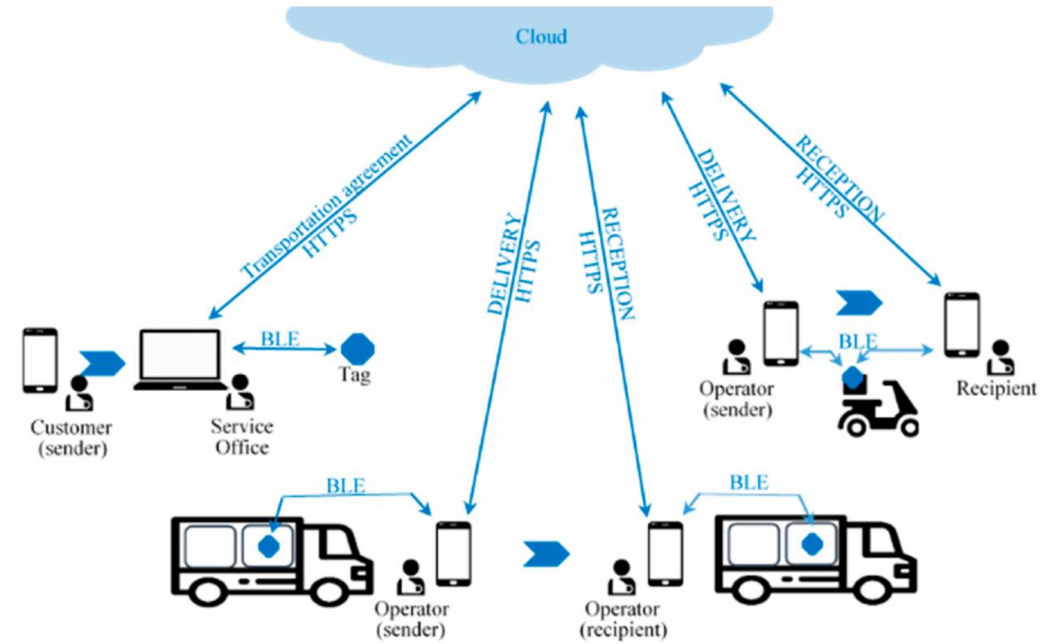
Figure 2. High-level architectural